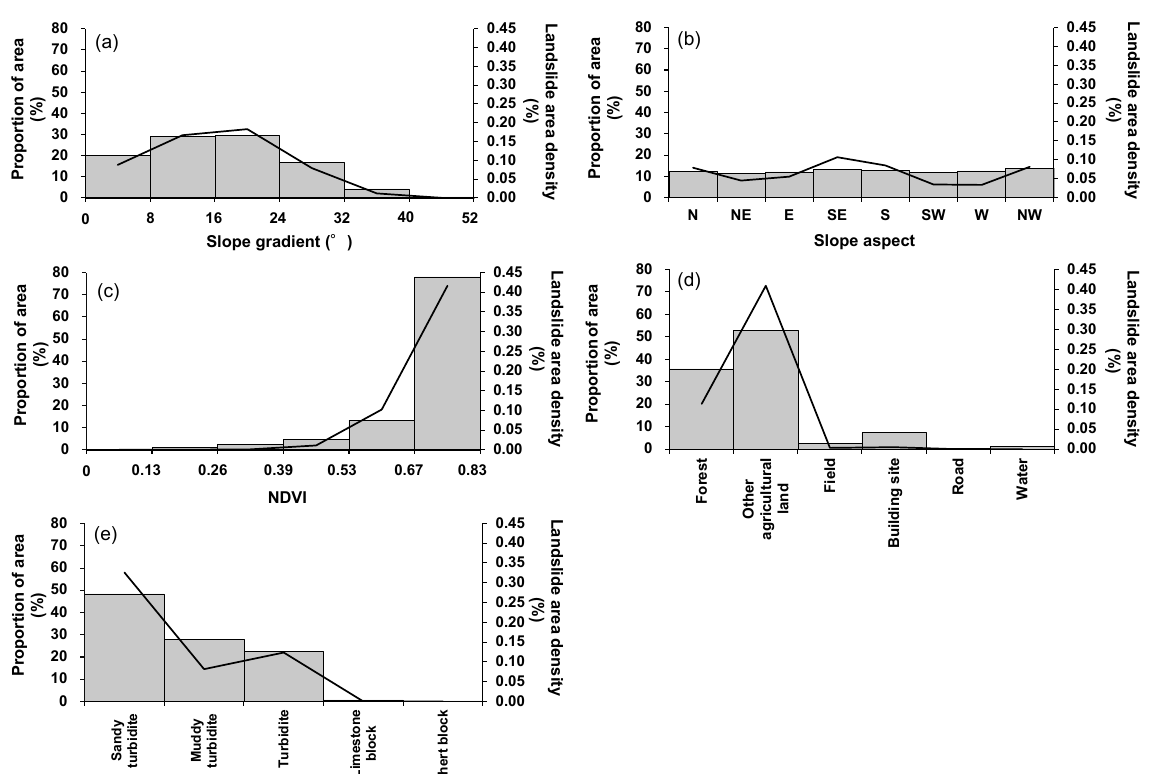
Figure 4. Proportion of area (bars) and landslide area density (lines) for each category of the five conditioning factors: ( a ) slope gradient; ( b ) slope aspect; ( c ) normalized difference vegetation index; ( d ) land use; and ( e ) geology.